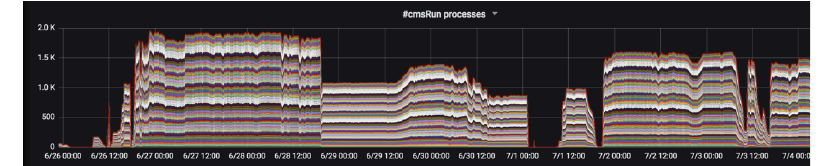
Fig. 3. Number of CMSSW processes running on the DODAS cluster. Each color is a distinct ​ process. The number of WNs are adjusted depending on the memory consumption as required by